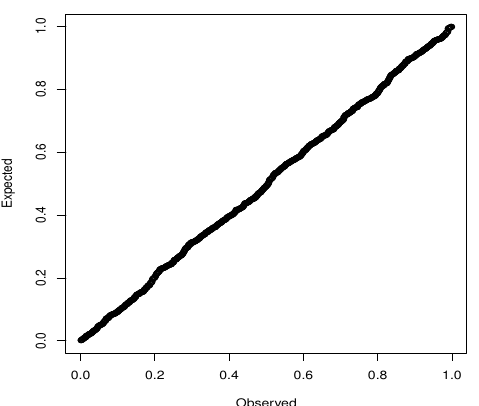
Figure 3. The P-P plots of the best fitting distributions for daily log returns of the exchange rates of Bitcoin (first row, left), Dash (first row, right), Dogecoin (second row, left), Litecoin (second row, right), MaidSafeCoin (third row, left), Monero (third row, right) and Ripple (last row) from 23 June 2014 until 28 February